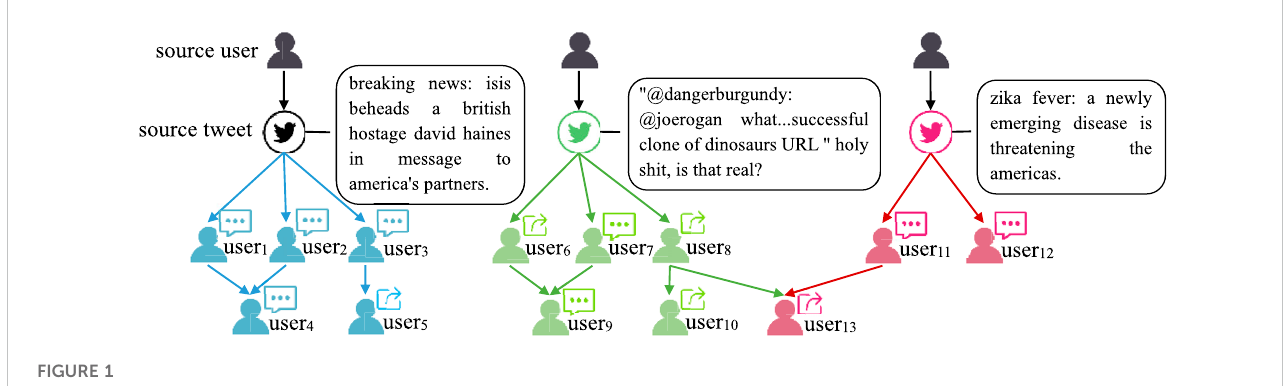
FIGURE 1 An example of news dissemination structures in social